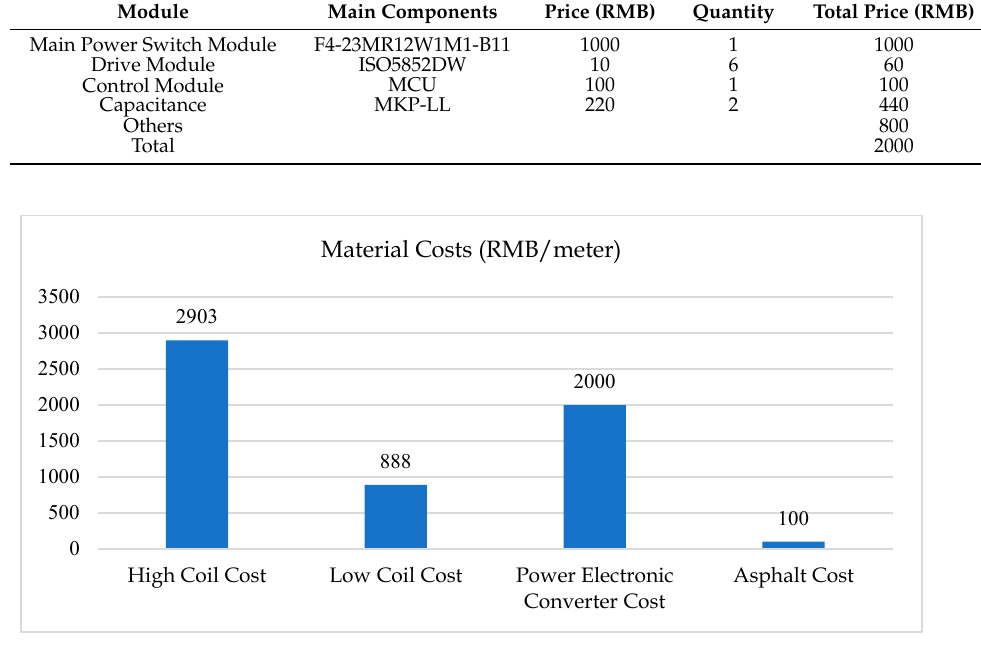
Figure 9. Material costs.